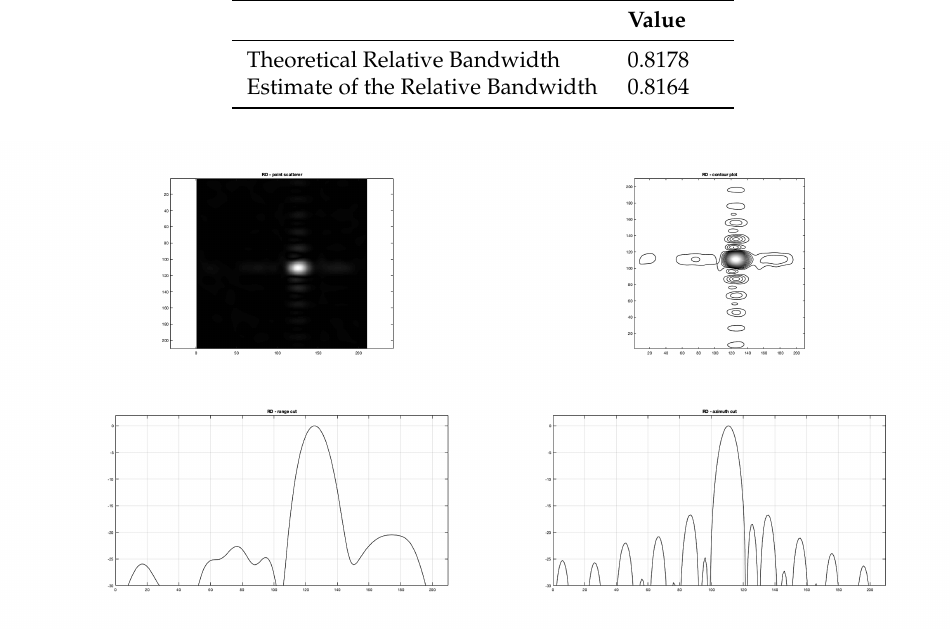
Table 3. Comparison of Theoretical and Estimated Chirp Relative Bandwidth.